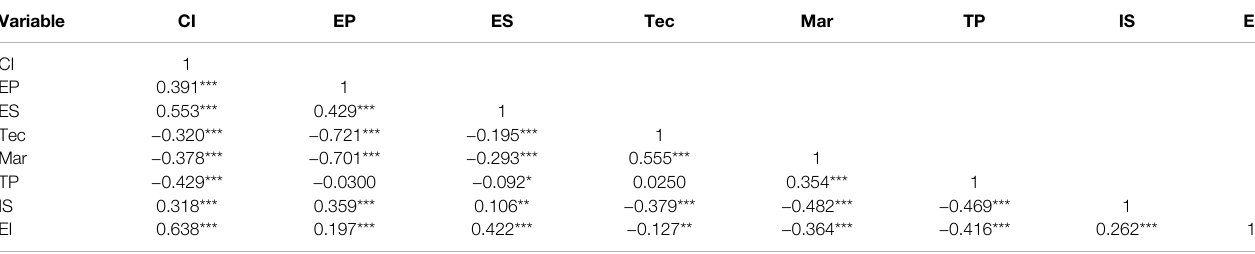
TABLE 3 | Pearson correlation coef fi cients. Variable